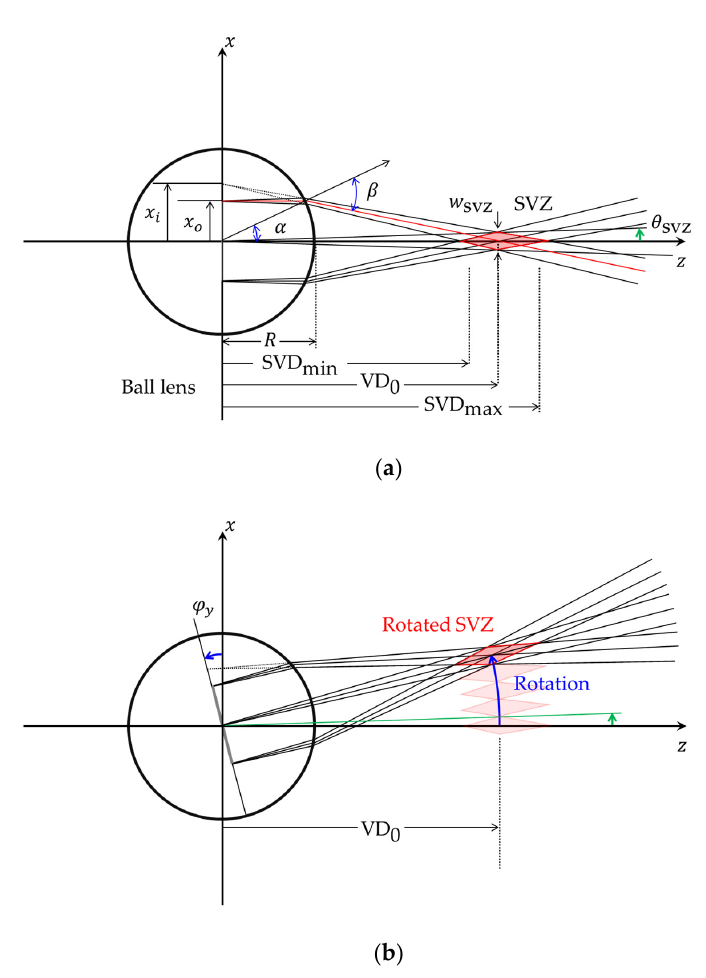
Figure 2. Formation of the sub-viewing zone (SVZ) in the proposed system. ( a ) Viewing distance range and width of the SVZ for the image inside of ball lens, and ( b ) change in location of the SVZ when the image is rotated around the y-axis.